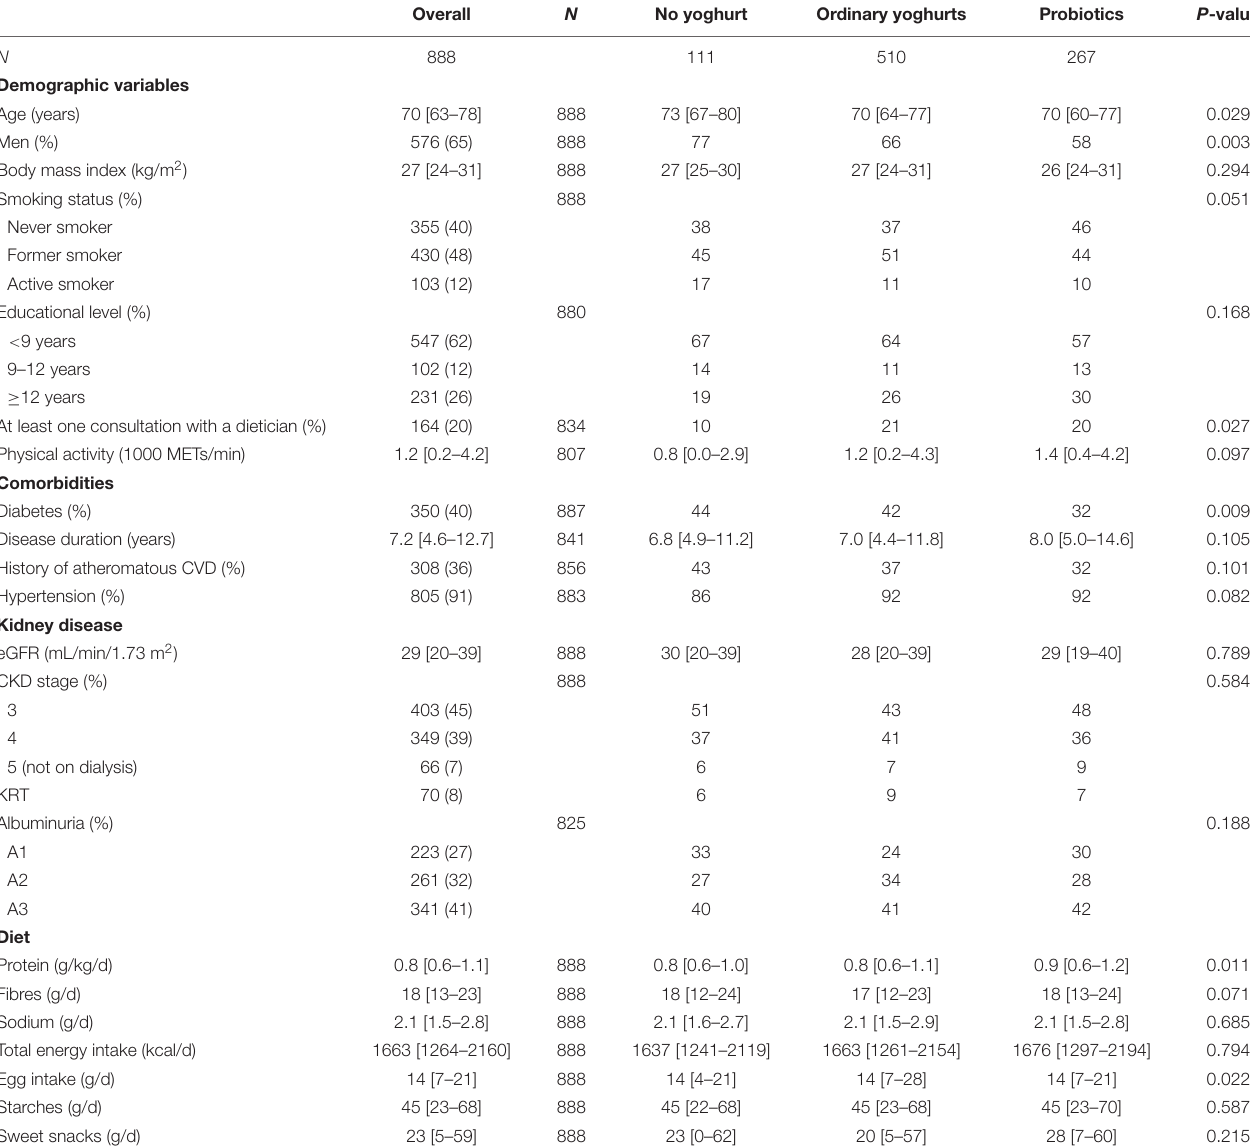
TABLE 1 | Characteristics of the study participants, overall and according to the intakes of ordinary yoghurt and probiotics. Overall